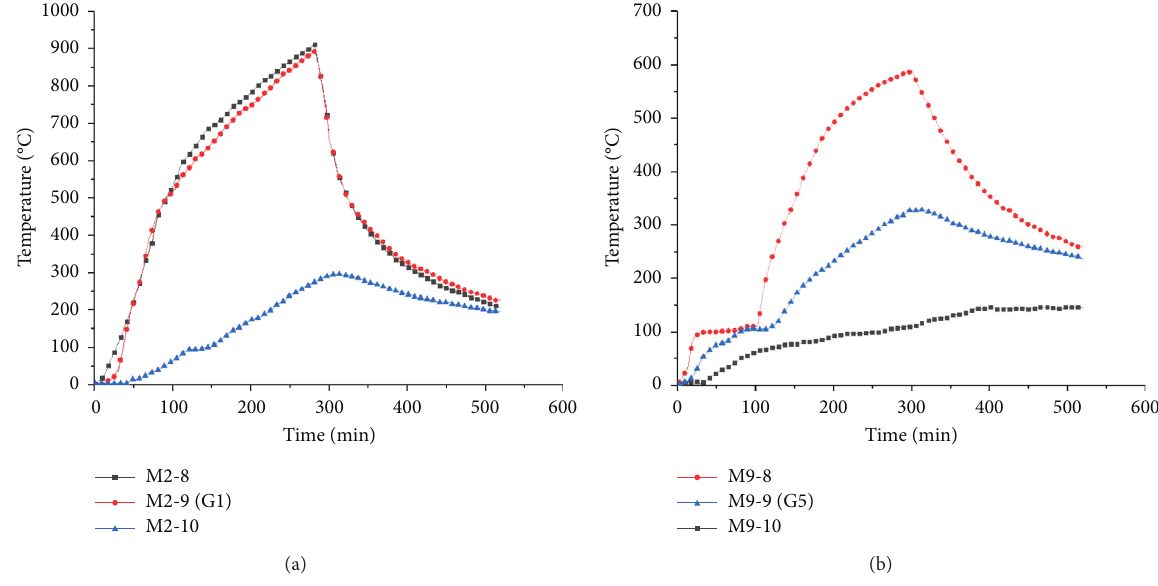
Figure 15: Temperature-time relationships of the congruent boxes. (a) M2 (G1); (b) M9